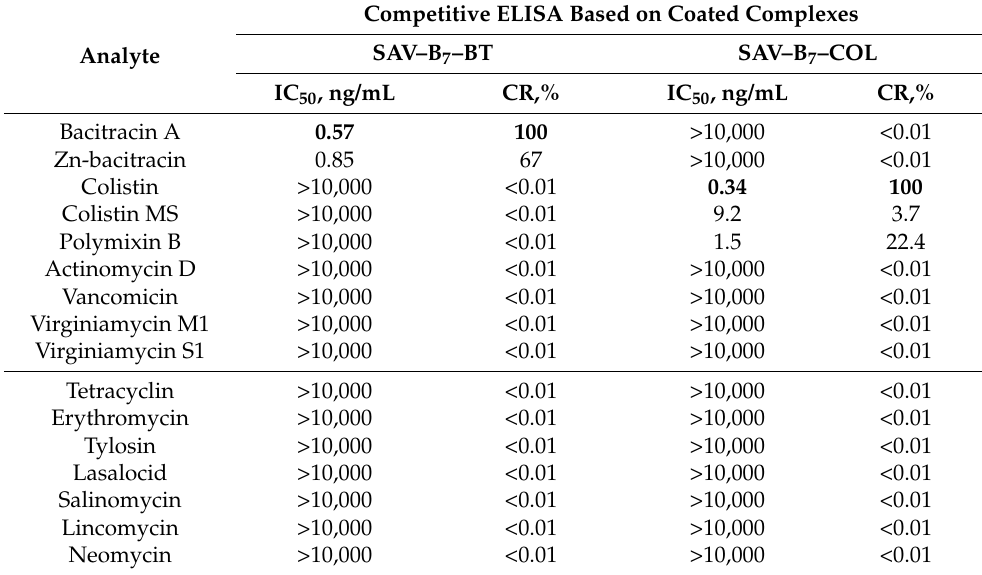
Table 2. Specificity of the ELISAs developed based on coated biotinylated haptens.